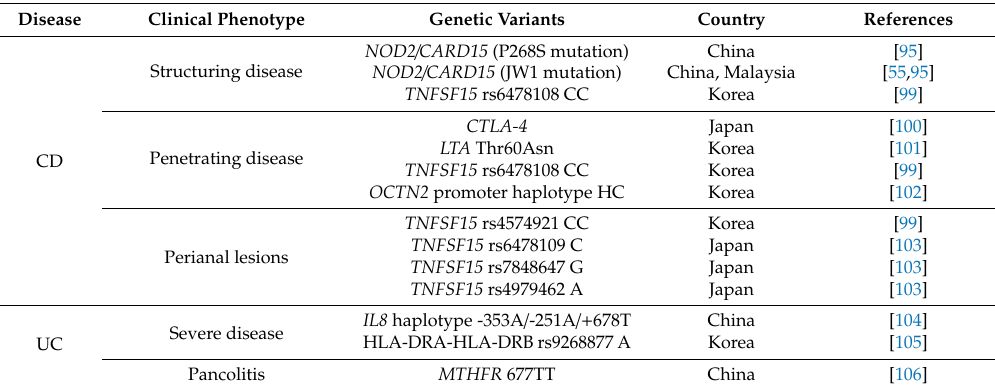
Table 2. Genetics and disease course in Asian studies